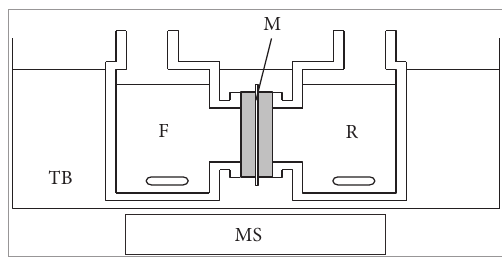
Figure 2: Scheme on the transport cell: M: SLM, F: feed source, R: receiving phase. TB: thermostated bath, and MS: multimagnetic stirrer.